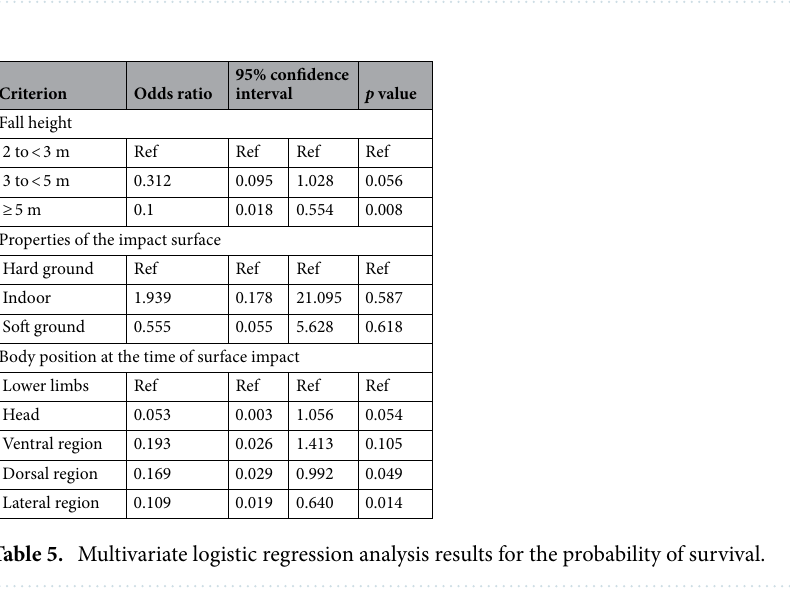
Table 4. Univariate logistic regression analysis results for the probability of survival.